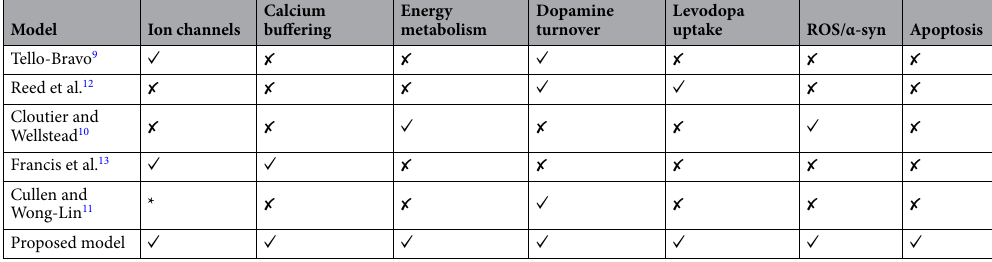
Table 1. Comparison of the proposed model with previously published models. *No ion channel dynamics but has spiking behavior (Izhikevich neuronal model 51 ).